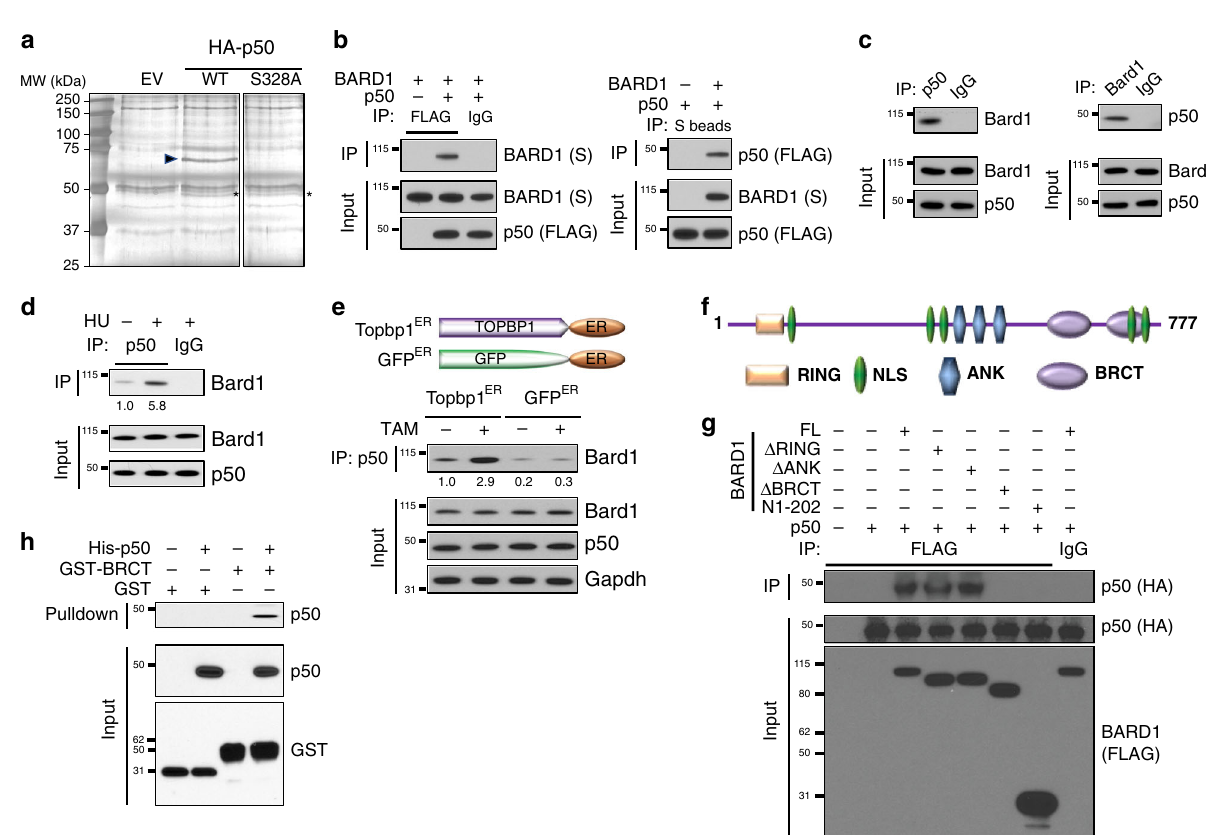
Fig. 1 p50 binds the BARD1 BRCT domains. a Silver stained gel of nuclear extract from 293T cells transfected with empty vector (EV), HA-p50 wt or HA- p50 S328A . Immunoprecipitation (IP) was performed with anti-HA. Asterisk indicates exogenous p50. Arrowhead, band analyzed by MS/MS. b Reciprocal Co-IP in 293T cells expressing S-tag BARD1 and FLAG-p50. IP with anti-FLAG (left) or S-agarose (right). Immunoblot (IB) with the indicated antibody. c Co-IP in primary wild type (WT) MEFs following IP of endogenous protein and IB with indicated antibodies. d Co-IP in WT MEFs treated with vehicle or HU (2 mM, 4 h). IP with anti-p50 and IB with anti-Bard1. e WT MEFs expressing TopBP1 ER or GFP ER were treated with tamoxifen (TAM, 4 h). IP with anti- p50 and IB with anti-Bard1 or indicated antibody. Inset: schematic of TopBP1 ER or GFP ER . f Schematic representation of BARD1 (ANK, ankyrin repeat). g Co- IP in 293T cells transfected with FLAG-BARD1 deletion constructs (FL, full length; N1-202, amino acids 1-202) and HA-p50. IP performed with anti-FLAG and IB with anti-HA. h Nickel column puri fi cation of 6xHis-p50 incubated with GST-BRCT or GST alone. Eluted proteins were examined with anti-p50 antibody. Input sample was probed with anti-p50 or anti-GST. All blots are representative of at least two biologically independent experiments. Analysis of fold-change normalized to control lane shown below IB where